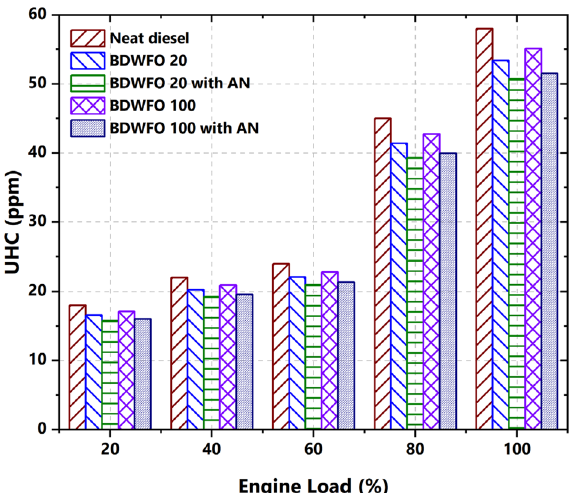
Figure 10. Emission of unburnt hydro carbons—UHC versus variation on load (%).